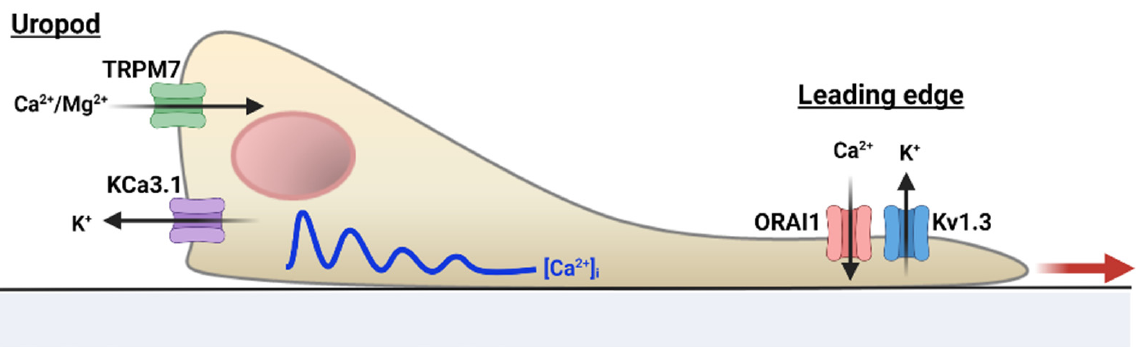
Figure 2. Ion channel regulation of human T cell motility. Ion channels acquire a distinct polarization in migrating human T cells: KCa3.1 and TRPM7 localize at the uropod, while Kv1.3 and CRAC (ORAI1) are at the leading-edge. Intracellular Ca 2+ levels ([Ca 2+ ] i ) are higher at the uropod than other cell compartments, which may serve to support the Ca 2+ requirements for cell motility. The blue line indicates intracellular Ca 2+ oscillations; the red arrow indicates directionality of movement. While KCa3.1 channels play an important role in integrin- and chemokine-driven migration, they do not seem to regulate trans-endothelial migration [21,33,40,47]. Indeed, Sim and colleagues (2017) showed that a KCa3.1 inhibitor reduced the migration of human CD8 + T EM cells that express high levels of interleukin (IL)-7 receptor alpha (IL-7R α ) chain on